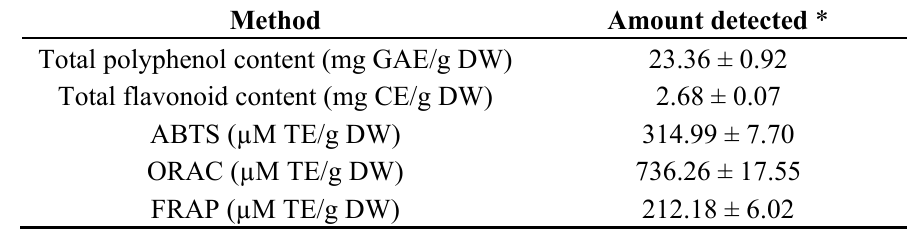
Table 1. Polyphenol and flavonoid content and antioxidant activity of A. annua